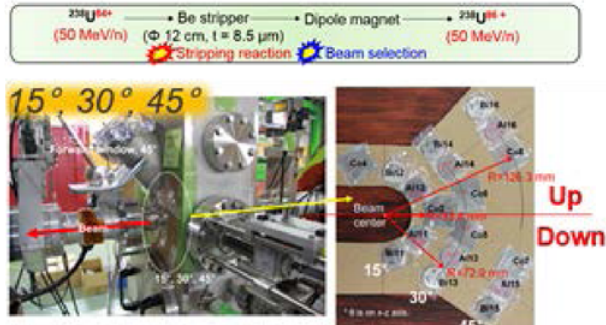
Figure 1 : Experimental setup at a charge stripper chamber and the arrangement of activation samples at the forward direction. (Charge stripping process is described